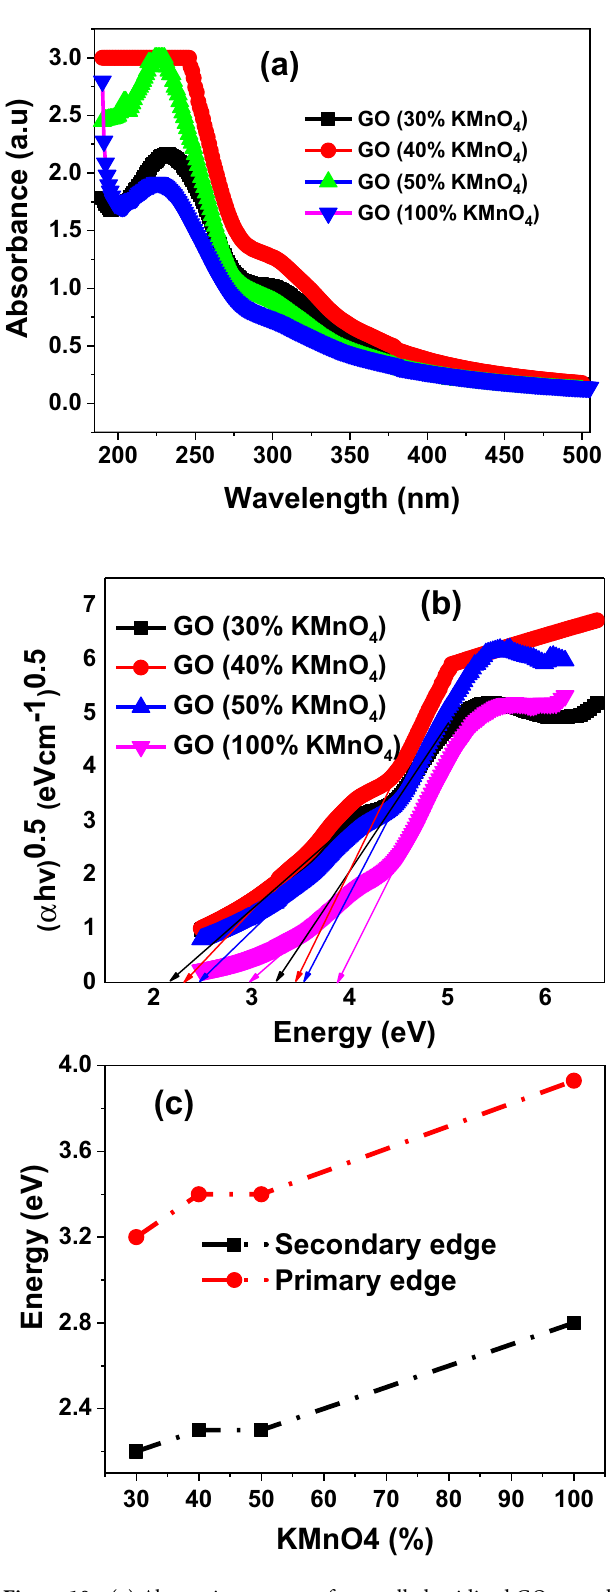
Figure 10. ( a ) Absorption spectra of controlled oxidized GO nanosheet samples ( b ) Tauc plots of controlled oxidized GO nanosheet samples ( c ) Variation in optical bandgap of controlled oxidized GO nanosheet samples versus amount of oxidizing